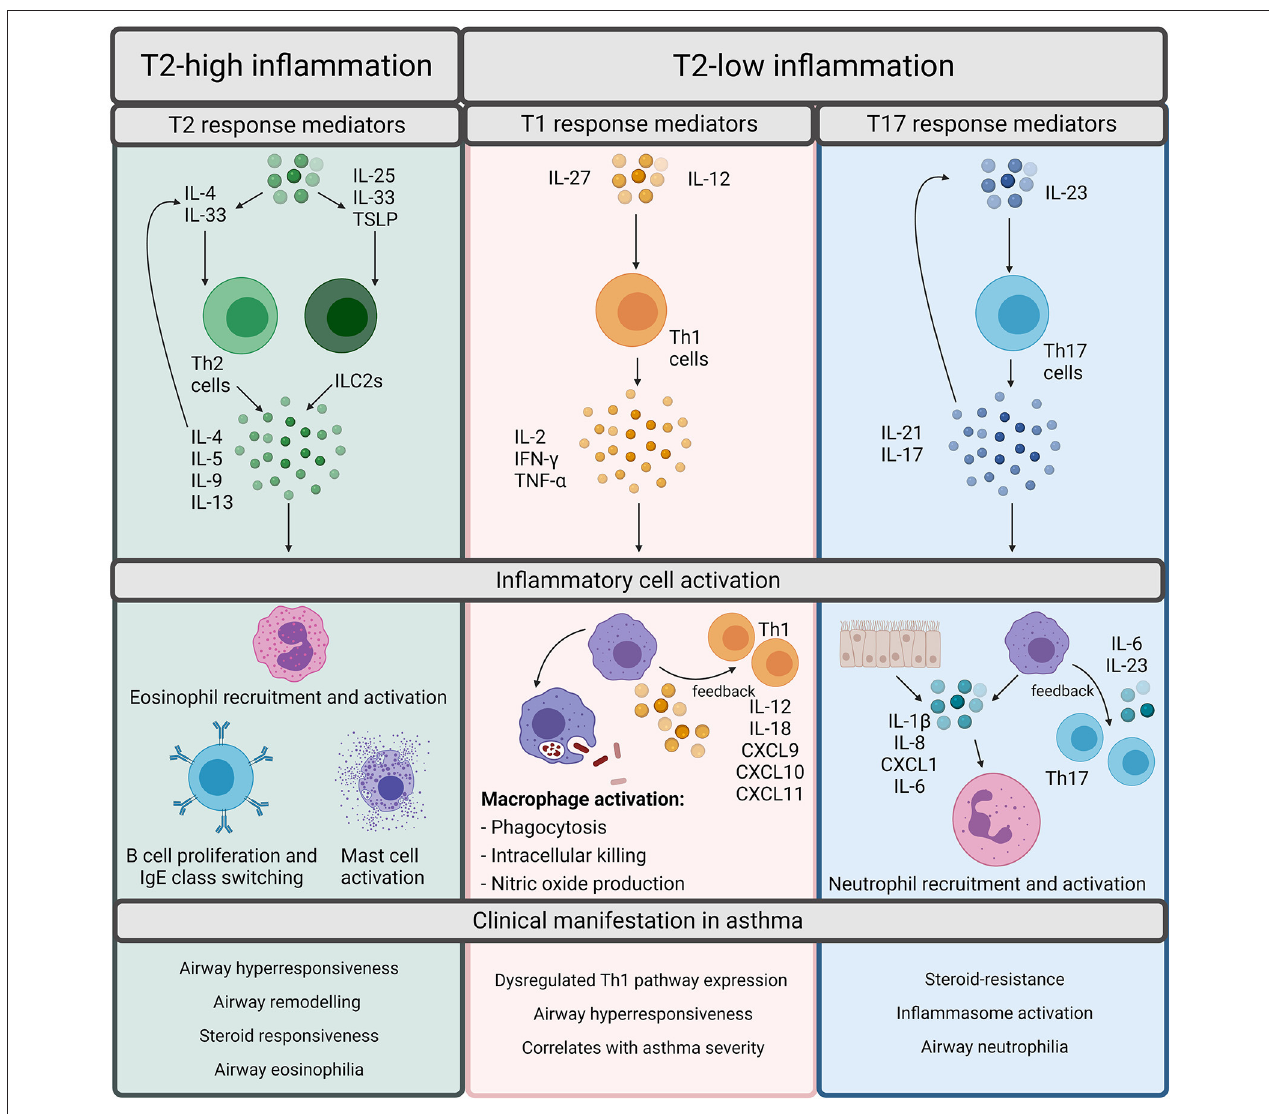
FIGURE 1 | Overview of inflammatory pathways in asthma. Inflammation in asthma is defined as Type (T)2-high or T2-low. T2-high inflammation is characterized by T2 cytokines such as interleukin (IL)-4, IL-5, IL-9, and IL-13. These cytokines can be released by T helper (Th) 2 cells or innate lymphoid group 2 cells (ILC2s). Th2 cells are stimulated by IL-4 whereas ILC2s are stimulated by IL-25, IL-33, or Thymic Stromal Lymphopoietin (TSLP). The T2 cytokines promote the cellular features of T2 inflammation including eosinophil recruitment and activation, B cell proliferation, IgE class switching, and mast cell activation. Although T2 inflammation is generally responsive to steroids, it results in the classical pathophysiological features of asthma including airway hyperresponsiveness, remodeling, and eosinophilia. T2-low responses are often associated with T1 or T17 inflammation. T1 inflammatory responses are regarded as important for defense against intracellular pathogens and are driven by Th1 cells, which are activated upon stimulation by either IL-27 or IL-12. Th1 cells release IL-2, IFN- γ , or TNF- α which activates macrophages and promotes microbial killing. Macrophages also participate in positive feedback through production of IL-12/IL-18, CXCL9, CXCL10, and CXCL11 to amplify T1 inflammation. T17 responses are induced through IL-23 stimulation of Th17 cells. Th17 cells release IL-21 and IL-17 which can either autoregulate Th17 cell differentiation or can act upon epithelial cells or macrophages to release IL-1 β , IL-8, CXCL1, and IL-6 to promote neutrophil recruitment and activation. T17 responses are associated with the neutrophilic asthma phenotypes, inflammasome activation, and steroid-resistance in asthma. Created using